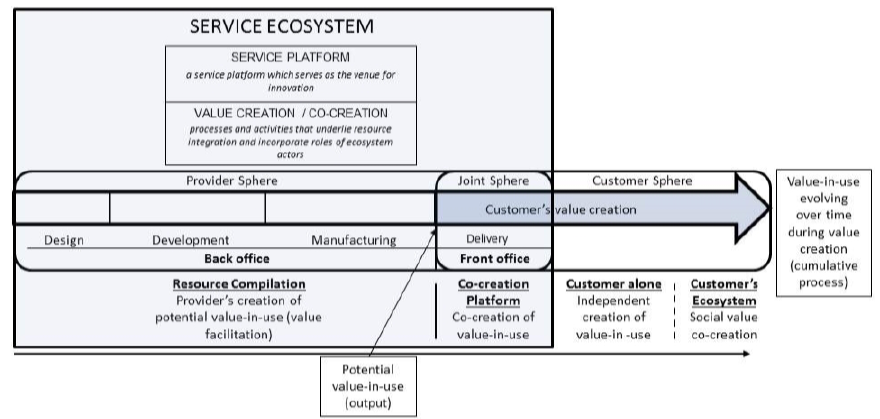
Fig. 3. The extended value generation process framework. Source: Adaptation of Grönroos and Gummerus (2014, p. 218) and Figure 1 of Lusch and Nambisan (2015, p. 162). Copyright © 2015, Regents of the University of Minnesota. Reprinted by